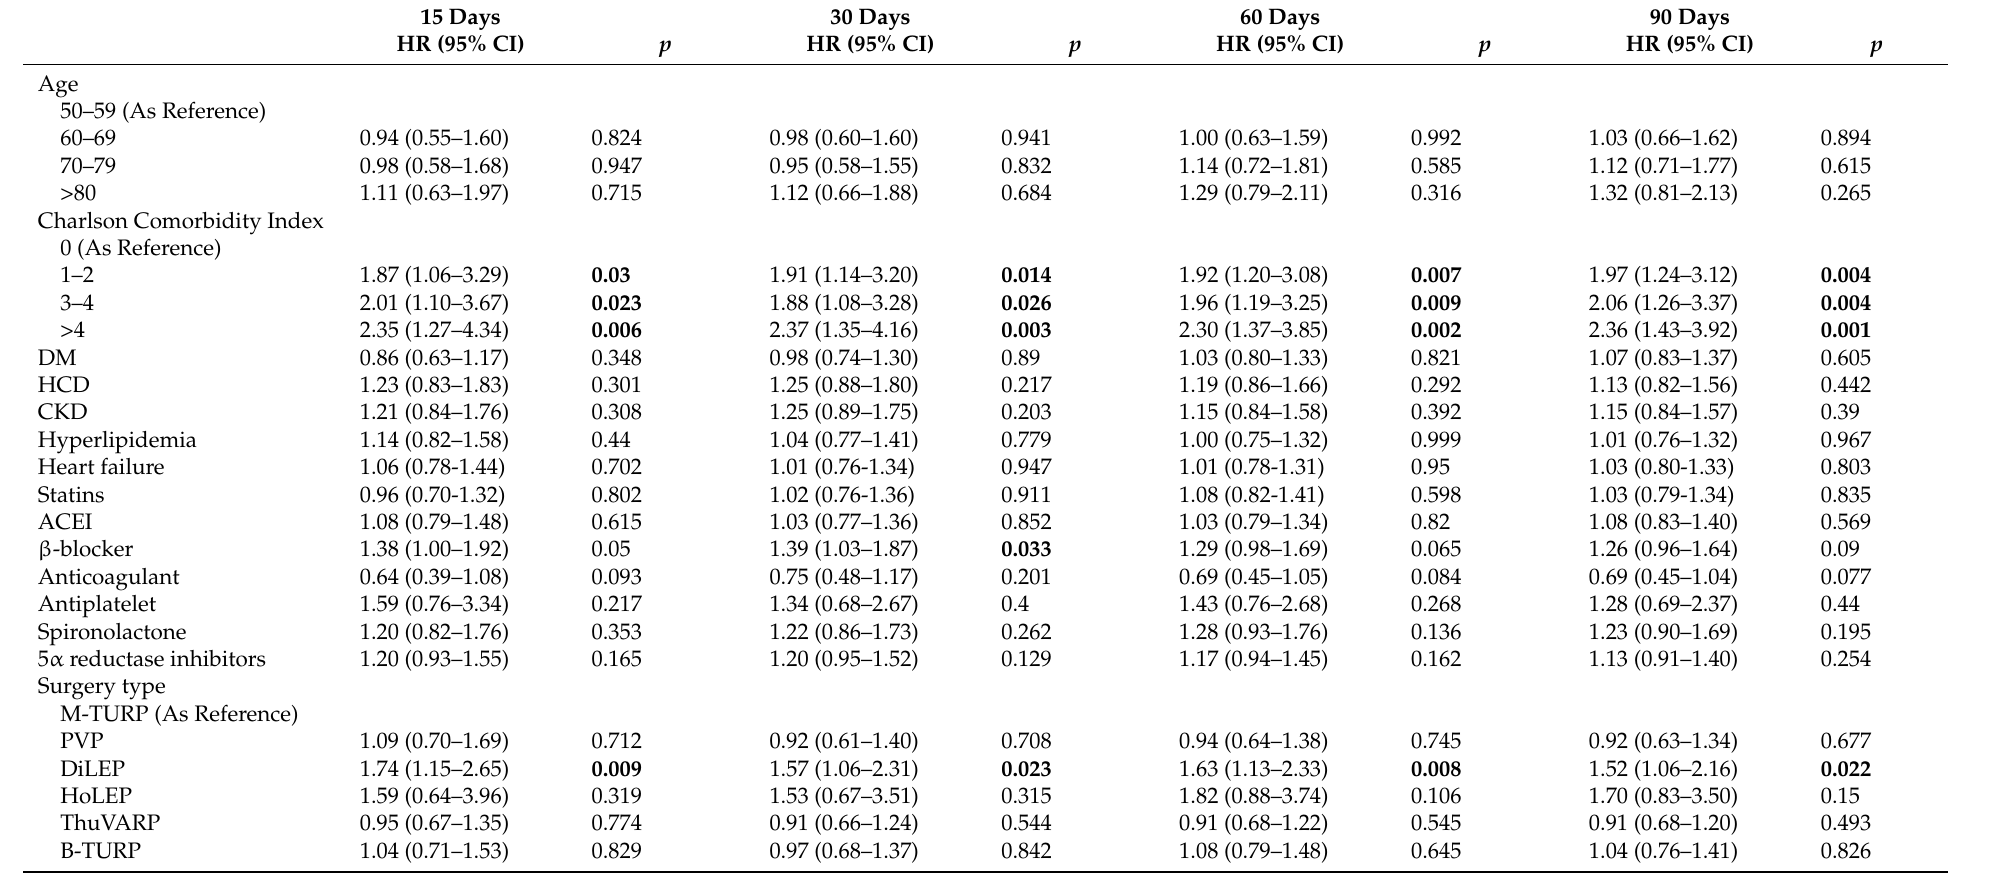
Table 4. Adjusted hazard ratios for emergency room visits due to postoperative bleeding after 15, 30, 60, and 90 days of